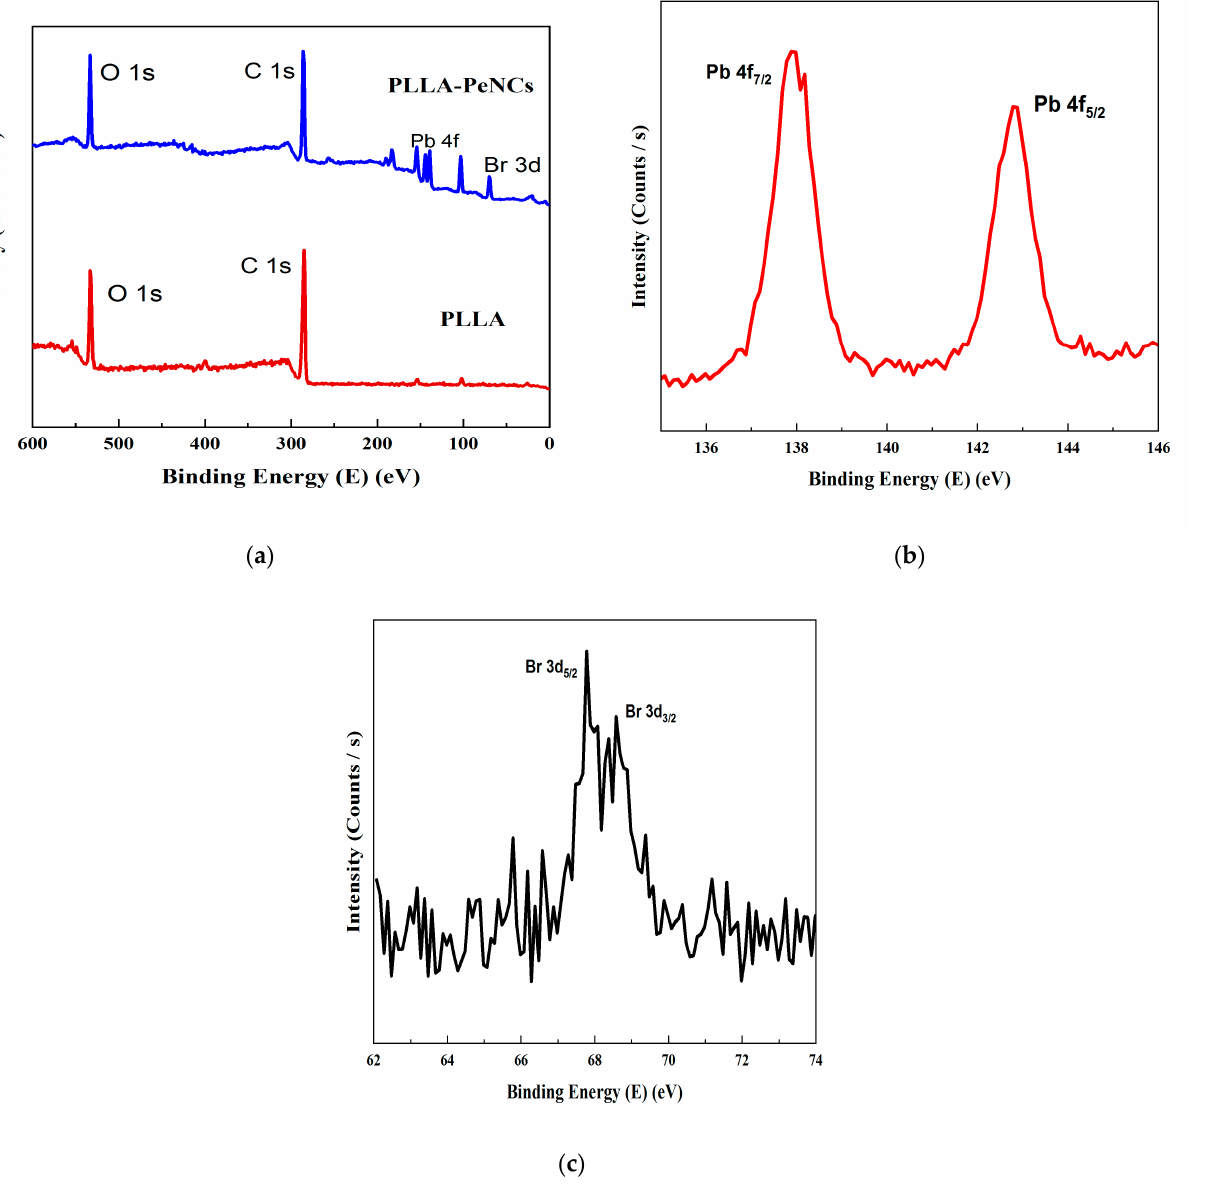
Figure 6. XPS analysis of ( a ) PLLA and PeNCs- PLLA nanofibres. ( b , c ) Pb 4f and Br 3d XPS spectra of composite nanofibres.